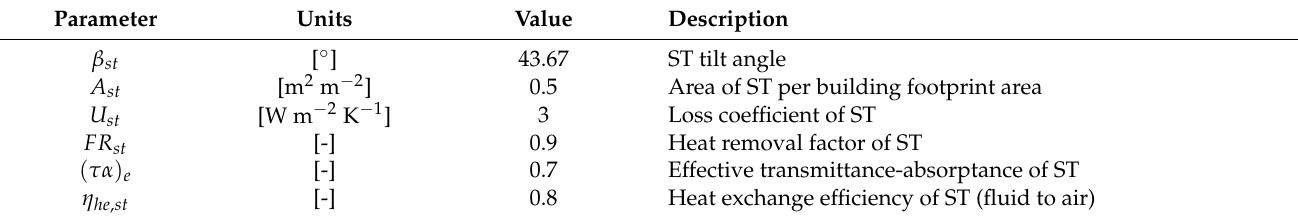
Table 2. Initial parameters for the renewable and alternative energy system; system components involve Solar Thermal (ST), PhotoVoltaic (PV), Wind Turbine (WT), Building Integrated Thermal Energy Storage (BITES) system, Phase Change Material (PCM), Heat Pump (HP), and heat recovery